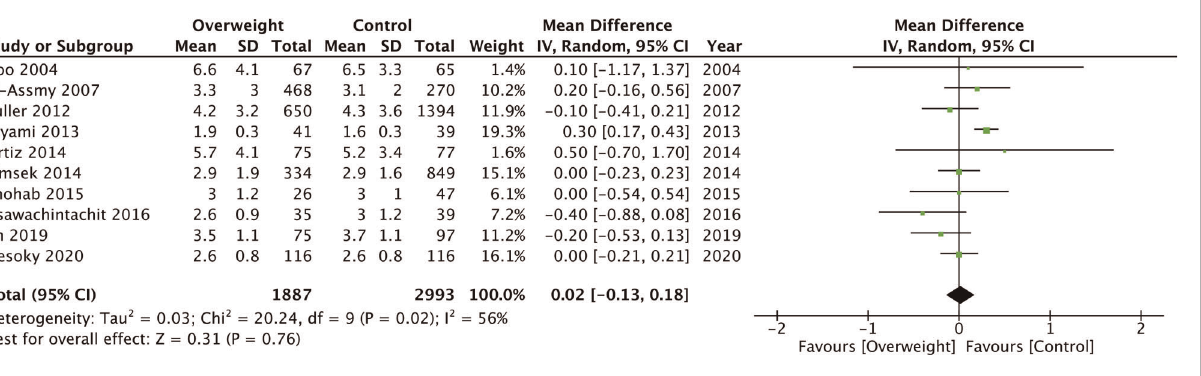
FIGURE 9 | Meta-analysis of LOS between overweight vs